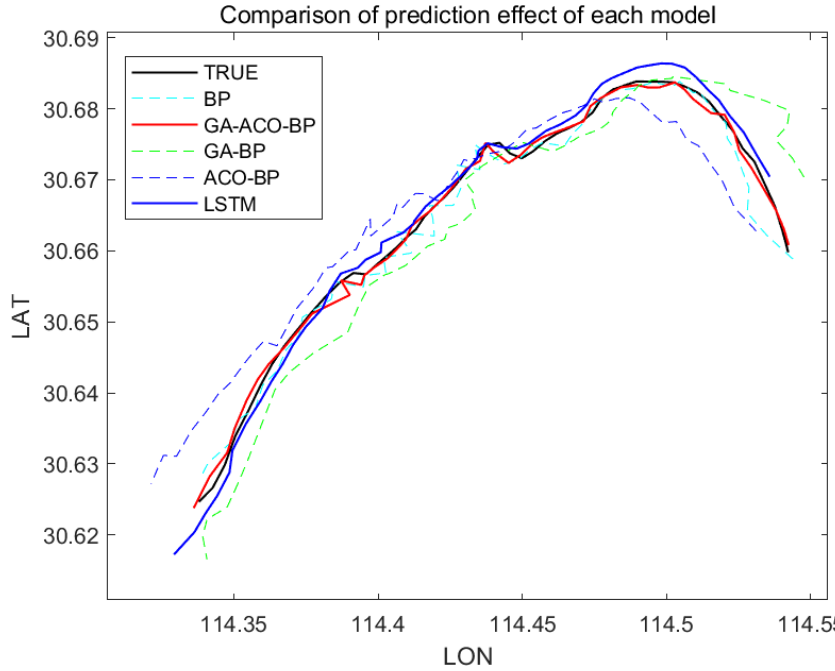
Figure 10. Comparison of track prediction effects of each model (Wuhan section).